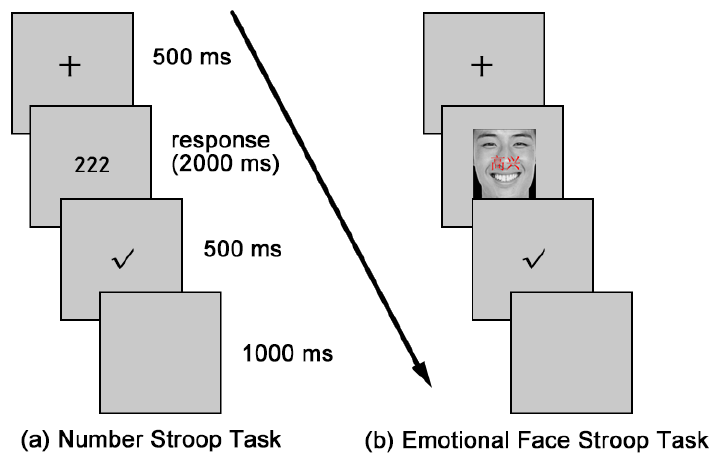
Figure 2. Schematic of trial sequences in cool and hot Stroop task. ( a ) Number Stroop task; ( b ) Emotional Face Stroop task. The words “ 高兴 ” in emotional face Stroop task means happy.